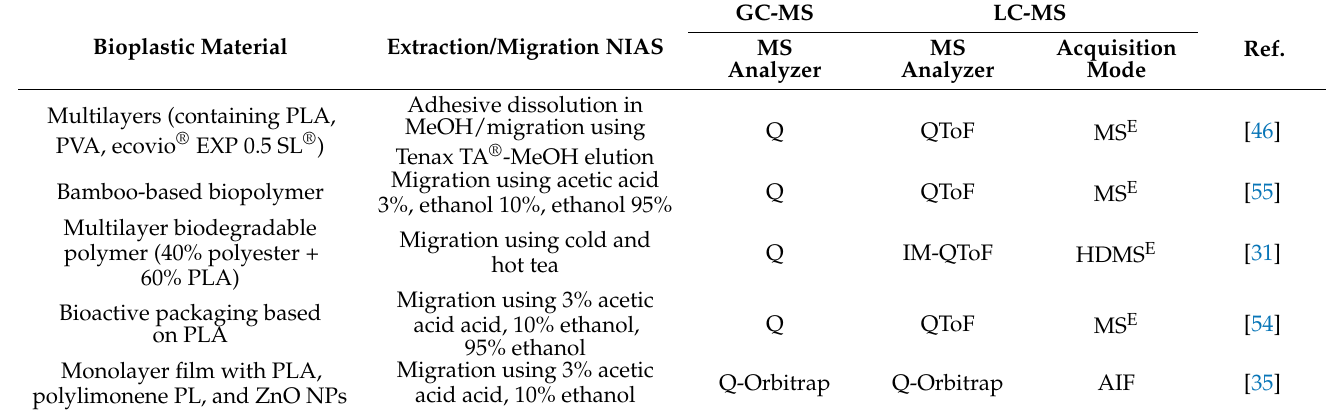
Table 3. Combined GC-MS and LC-MS methods for the investigation of NIAS in